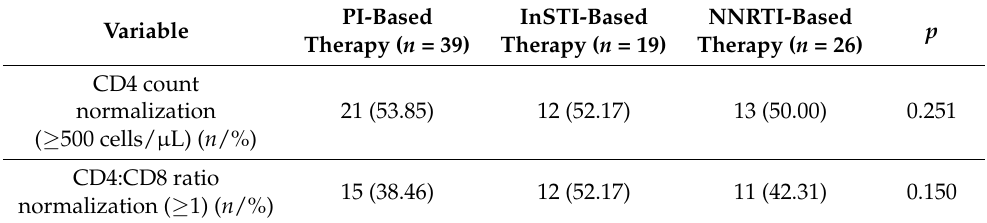
Table 7. CD4 cell count and CD4:CD8 normalization depending on the applied ART regimen.